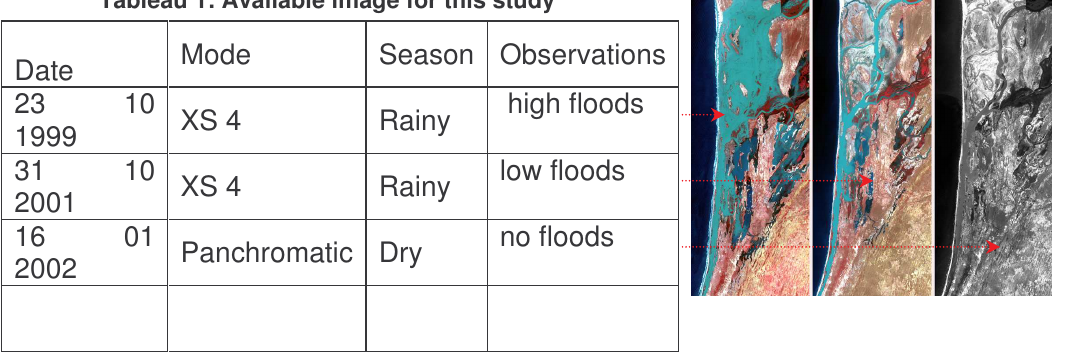
Tableau 1: Available image for this study